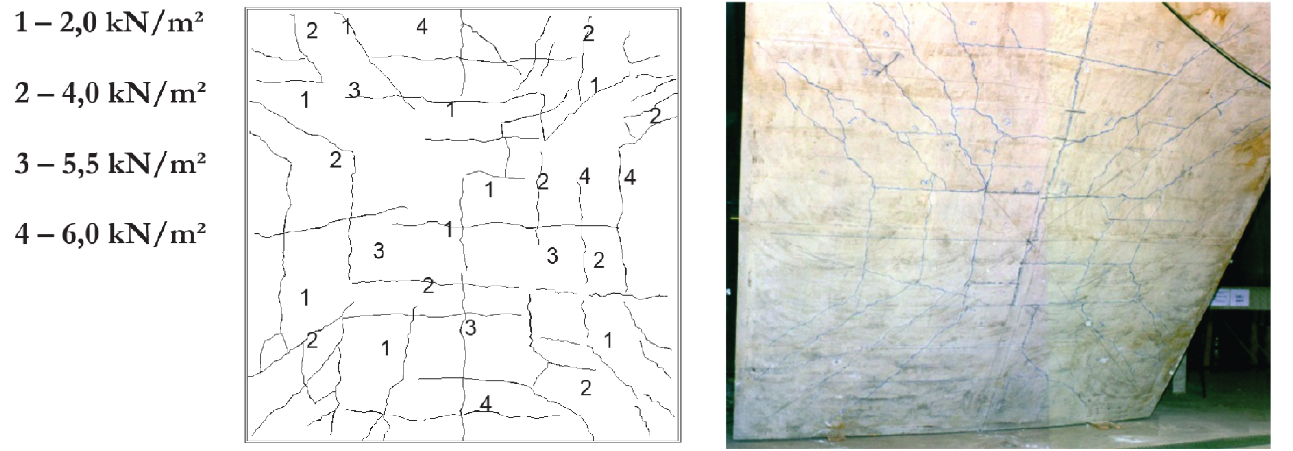
Scheme of cracks pattern of slab L1 and cracks of slab L2R after